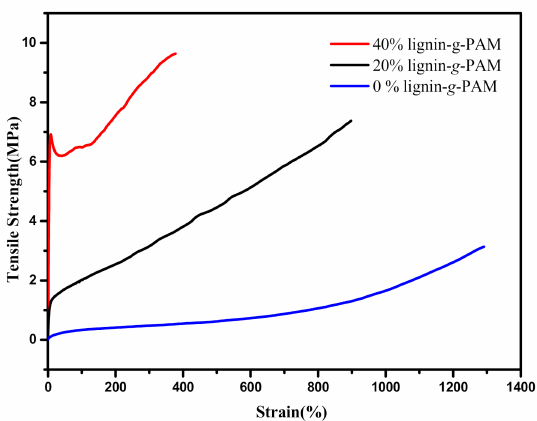
Figure 8. Strength–strain behaviors versus % of lignin-g-PAM for synthesis of lignin-grafted hybrid acrylic